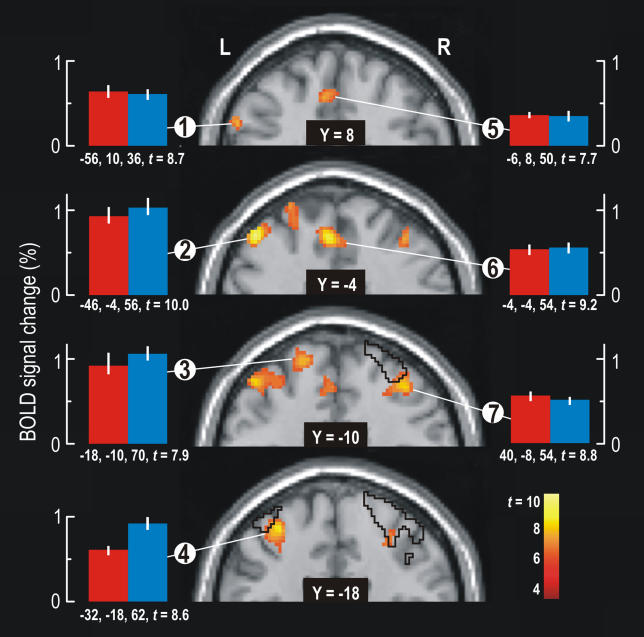
Premotor Cortical Areas with Increased BOLD Responses with Both the Left- and the Right-Hand Map Overlaid on Coronal Slices of the MNI T1-Weighted Brain TemplateFor the left hemisphere (L), significant activations (
p < 0.01, FWE-corrected) occurred in one cluster (443 voxels) with two maxima in precentral gyrus (#2 and #4; BA 6), in one single-peak cluster (153 voxels) in superior frontal gyrus (#3; BA 6), in one cluster (281 voxels) with two maxima in medial frontal gyrus (#5 and #6; BA 6), and in one small single-peak cluster (29 voxels) in left inferior frontal gyrus (#1; BA 44). In the right hemisphere (R), there was one cluster (303 voxels) with three maxima, one of which was located in the precentral gyrus outside the cluster delineated by left-hand-map > right-hand-map contrast (#7; BA 6). Solid black lines in the left and right hemisphere outline the clusters identified with the right-hand-map > left-hand-map and left-hand-map > right-hand-map contrasts, respectively (see
Figure 4C). Histograms give percent BOLD signal change relative to mean of session for the local maxima of identified clusters. Red and blue columns refer to left- and right-hand maps, respectively. Column height gives data averaged across participants and error bar ± 1SEM (
n = 16). Coordinates (X, Y, Z in MNI stereotaxic space) and
t
(30) values for the maxima are presented below each histogram.